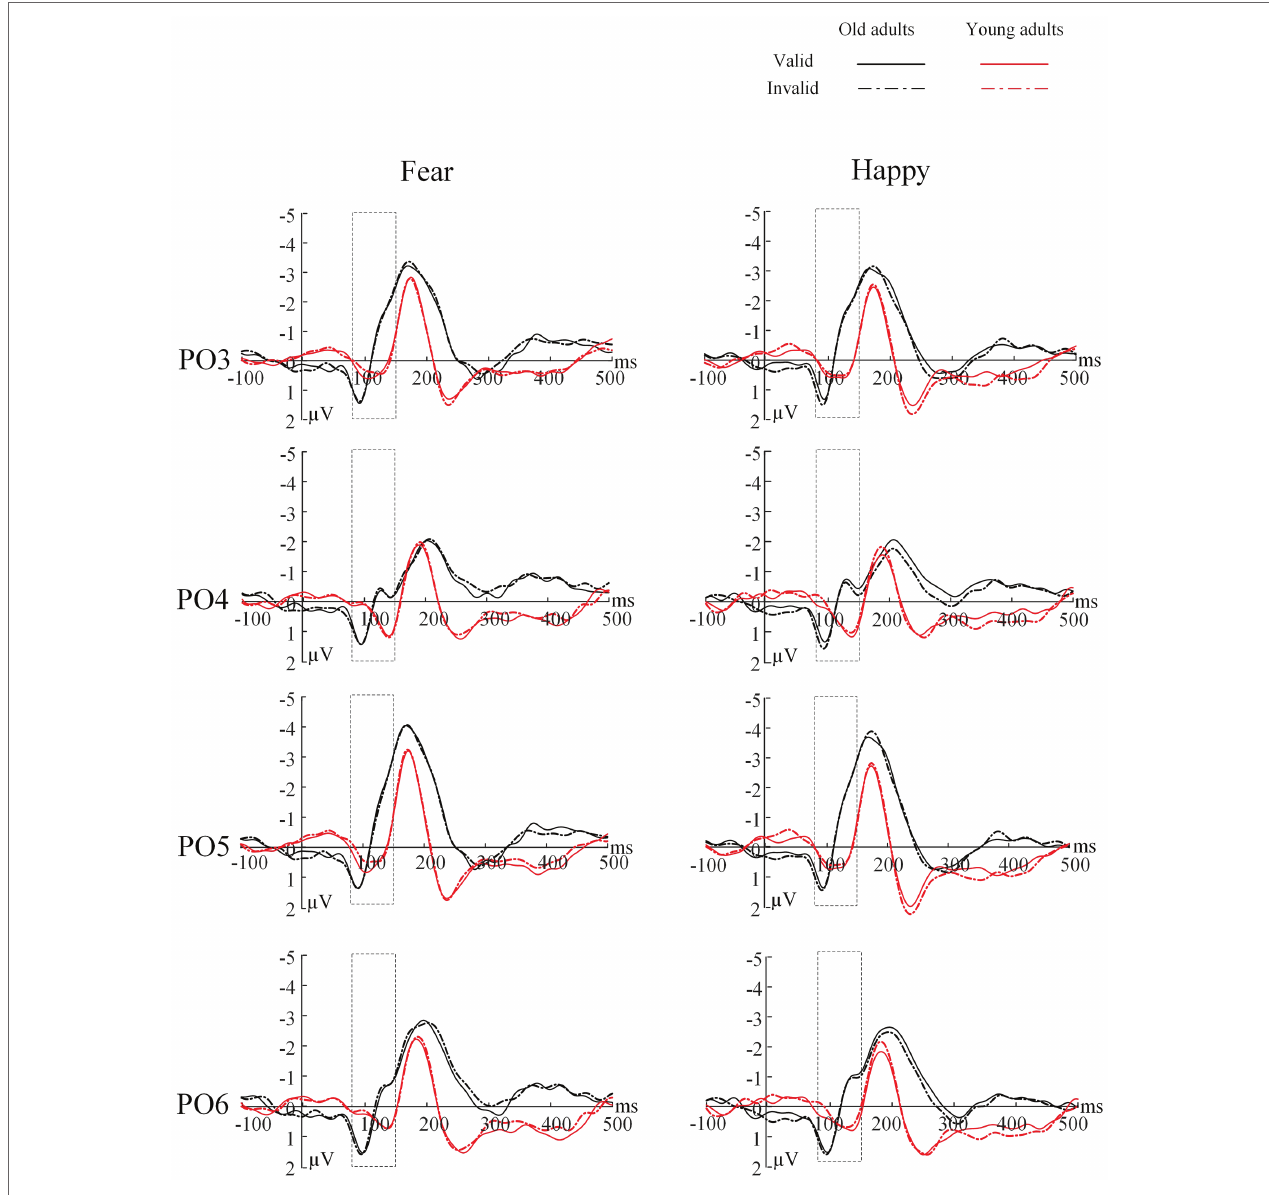
FIGURE 3 | Grand average ERP of the P1 component for each group at channels of PO3/PO4 and PO5/PO6. Solid lines = valid trials, dotted lines = invalid trials, black = older group, red = young group. The rectangular box represents the selected time